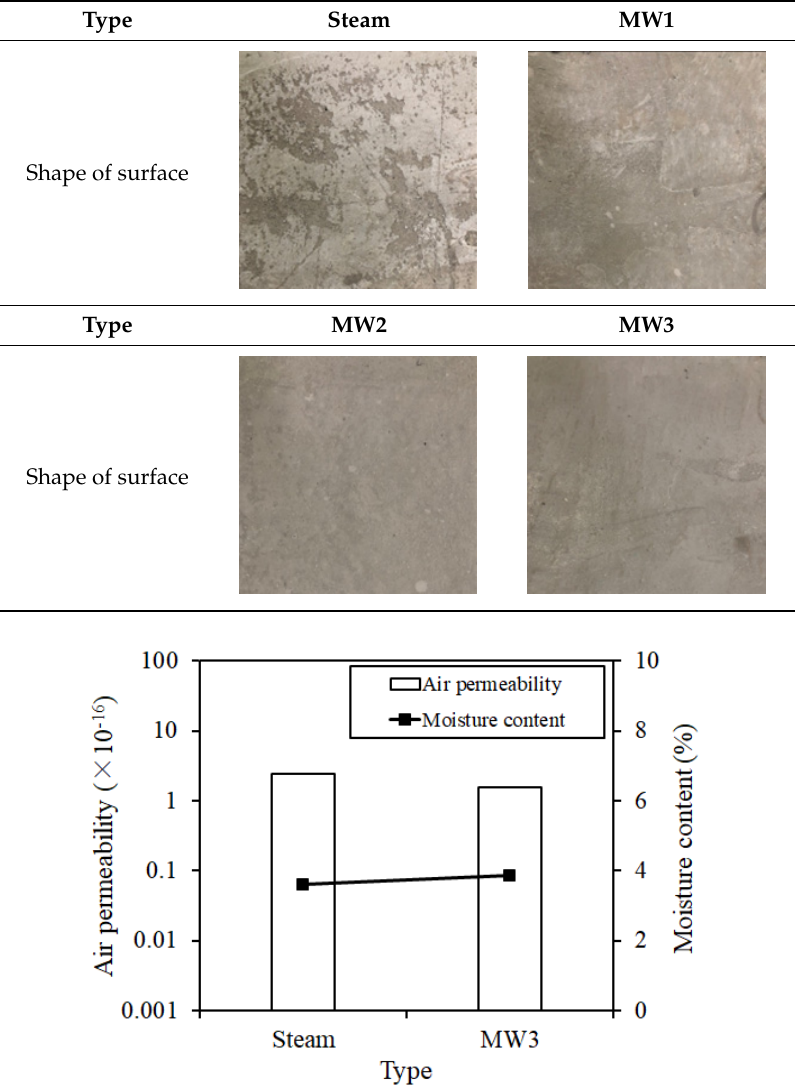
Table 6. Surface condition of concrete at the age of 28 days.